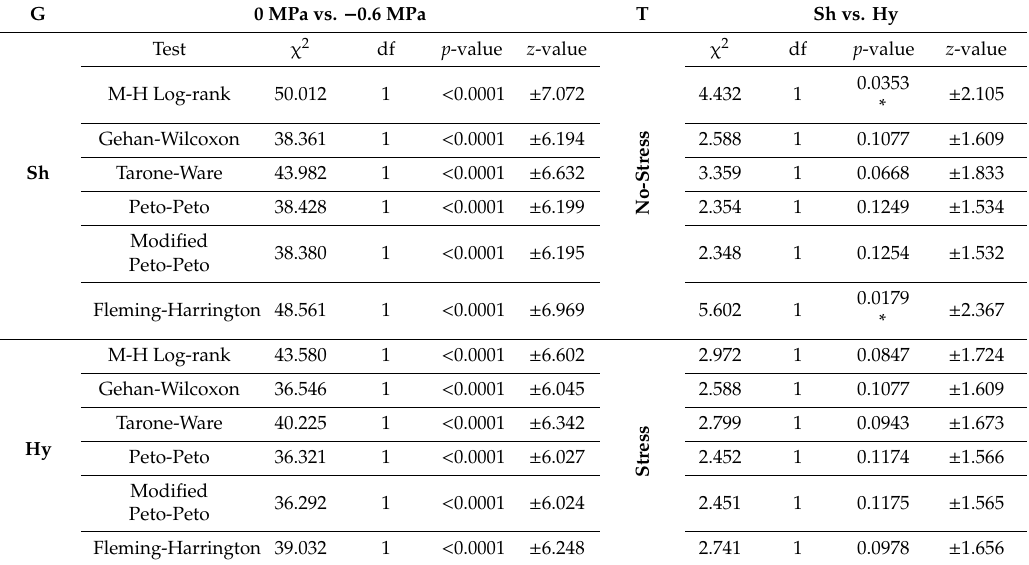
Table 1. Results of the comparison tests for survival functions between stress treatments within each genotype (left side of the table) and between genotypes for each treatment (right side of the table). The asterisk on p -values indicates a statistical significance ( α < 0.05). z -values are standardized. G stands for genotype, T for